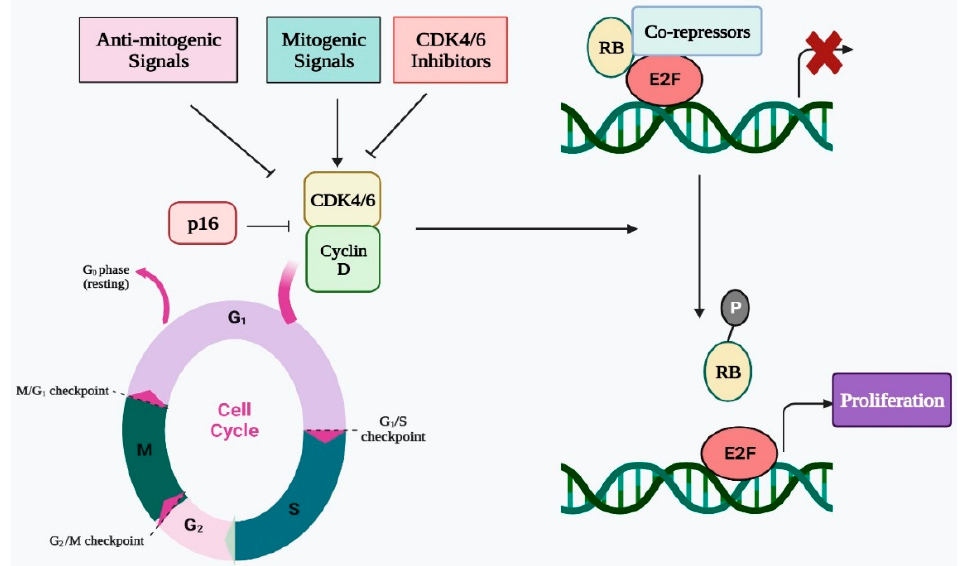
Figure 1. Regulatory role of CDK4/6 in cell cycle progression via E2F-Rb pathway.